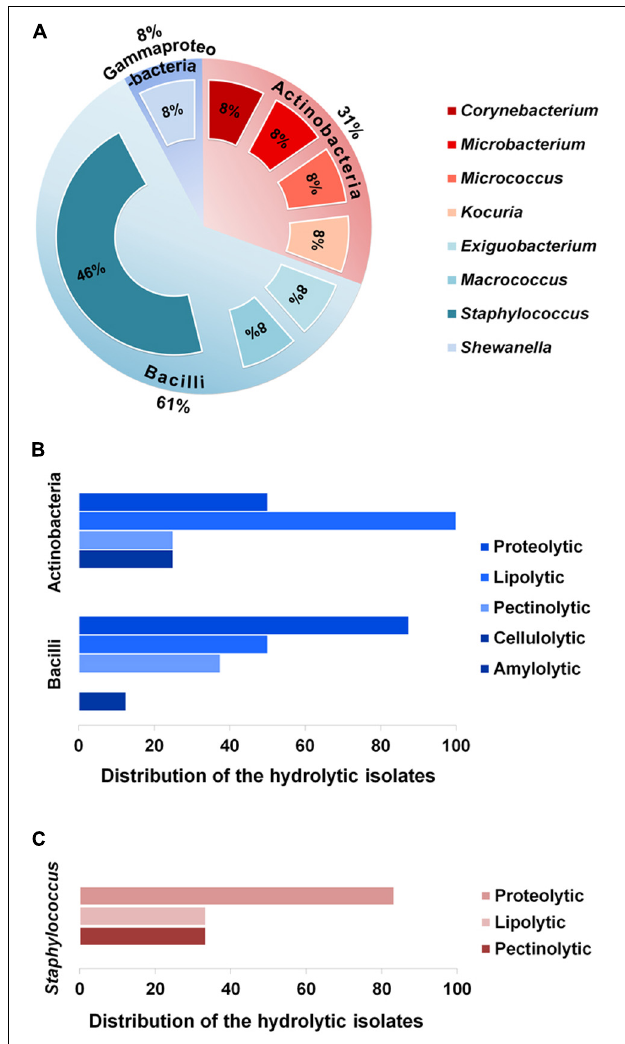
FIGURE 3 | Proportions of the various phylotypes of the enzyme-producing isolates, and distribution of the isolates across these phylotypes. (A) Proportions (%) of the taxonomic classes and genera representing the thirteen enzyme-producing isolates. (B) Distribution (%) of the hydrolytic isolates across the two major classes, i.e., Actinobacteria and Bacilli. (C) Distribution (%) of proteolytic, lipolytic and pectinolytic isolates across the major genus, Staphylococcus